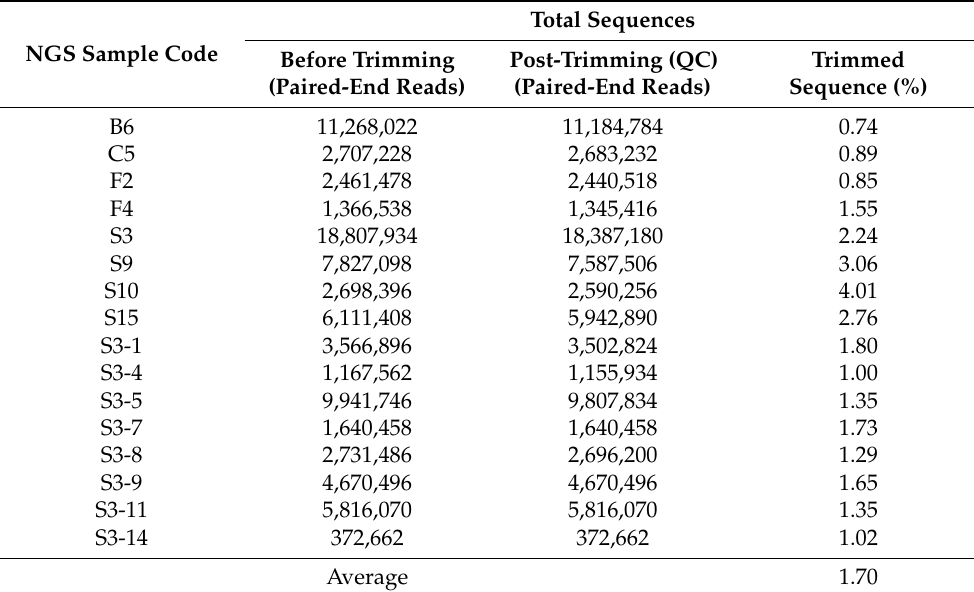
Table 3. Total sequences before and after quality control using